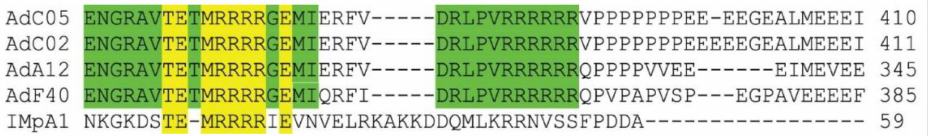
Figure 4. Protein sequence homology of the adenovirus bipartite nuclear localisation signal (NLS) and importin α . Sequence homology of amino acids in the NLS 1 region of adenovirus TP and importin α is highlighted in yellow. Sequence homologies between different adenovirus serotypes around NLS 1 and NLS 2 are highlighted in green. Adenoviruses are represented as “Ad” followed by “C, A, or F” for the species designation and numbers representing the serotypes. Importin α is aligned for comparison. Homology was performed using the Uniprot alignment